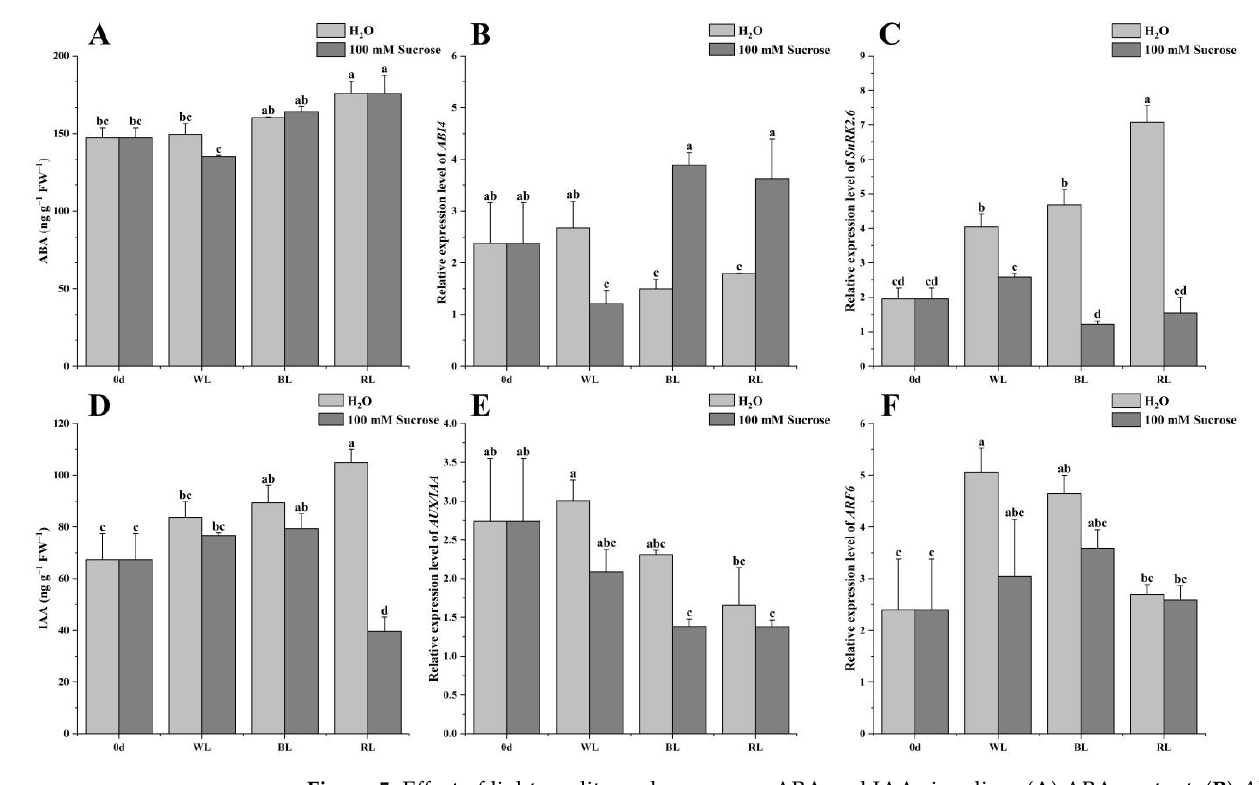
Figure 5. Effect of light quality and sucrose on ABA and IAA signaling. ( A ) ABA content, ( B ) ABI4 expression level, ( C ) SnRK2.6 expression level, ( D ) IAA content, ( E ) AUX/IAA11 expression level, ( F ) ARF6 expression level. Data represent the means ± standard error ( n = 3). Different lowercase letters indicate the statistically significant difference of the mean values based on one-way analysis of variance (ANOVA) followed by Duncan’s multiple range test ( p ≤ 0.05).